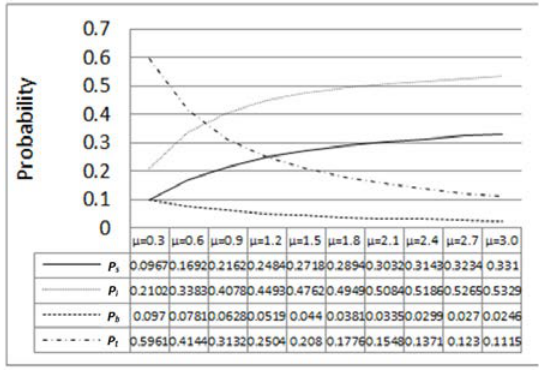
Figure 6: System service rate ( μ ) and the variation of probability in different state